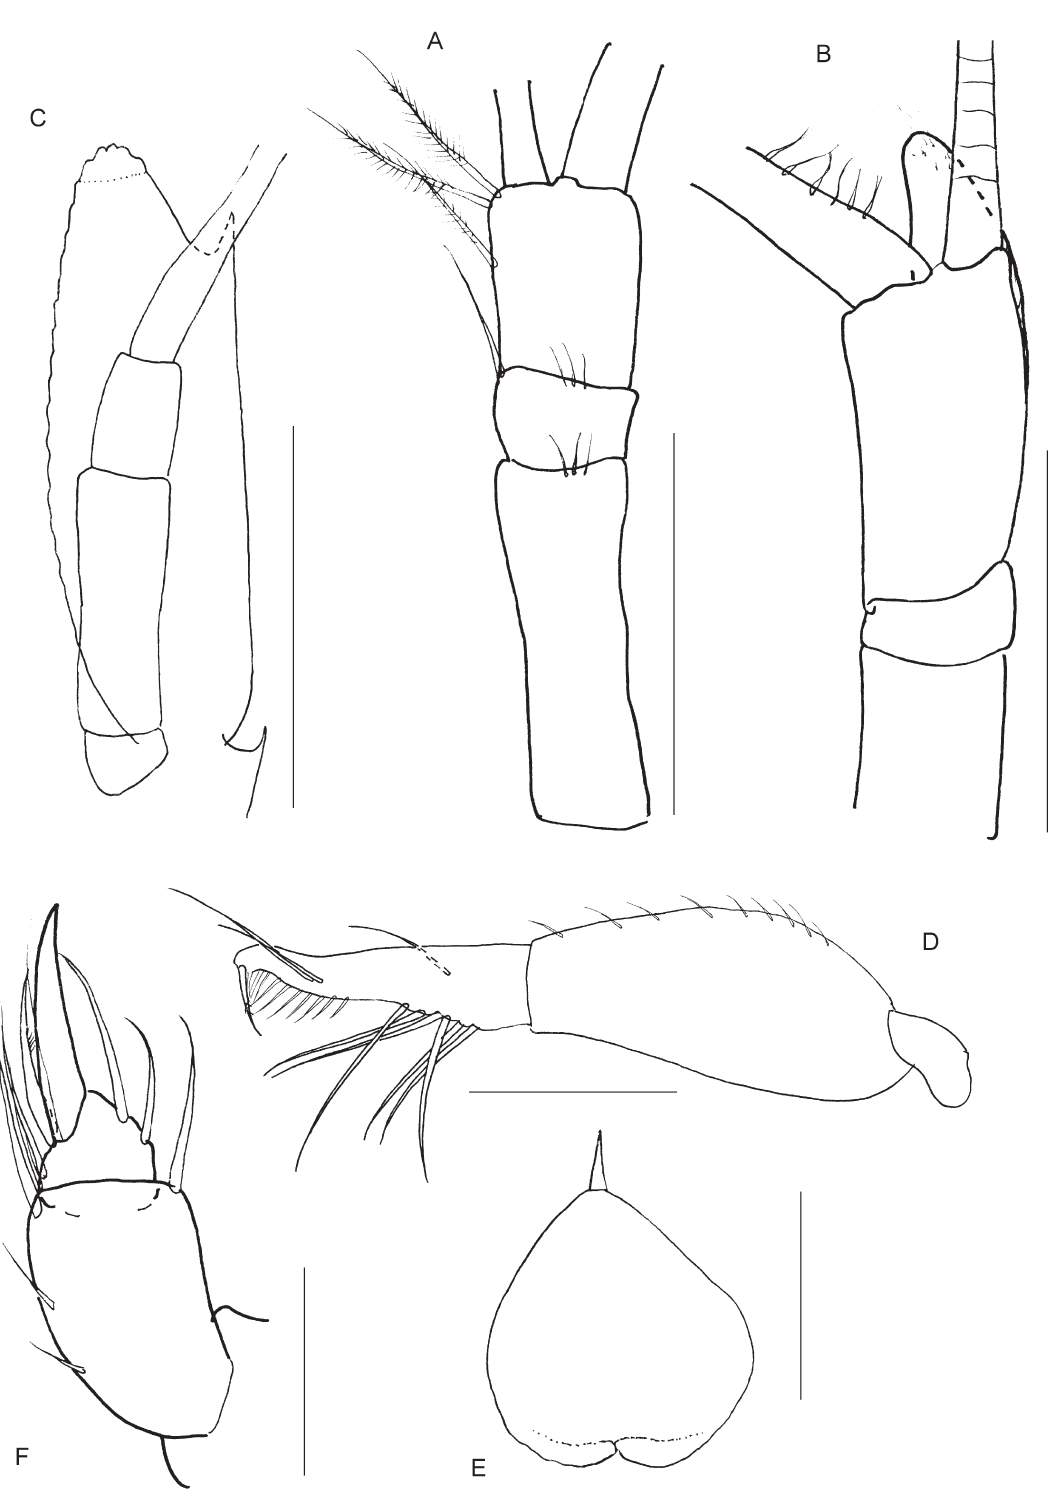
Fig. 30. Siriella vincenti W.M. Tattersall, 1927, syntypes, Gulf of St. Vincent, South Australia, Australia. A . Antenna 1 peduncle, dorsal view. B . Antenna 1 peduncle, dorsal view. C . Antenna 2 peduncle and antennal scale, ventral view. D . Mandibular palp, medial view. E . Labrum. F . Distal part of maxilliped 1 endopod, posterior view. A, C–F = ♀; B = ♂, length 7.5 mm. Scale bars: A–C = 0.5 mm; D–F = 0.25